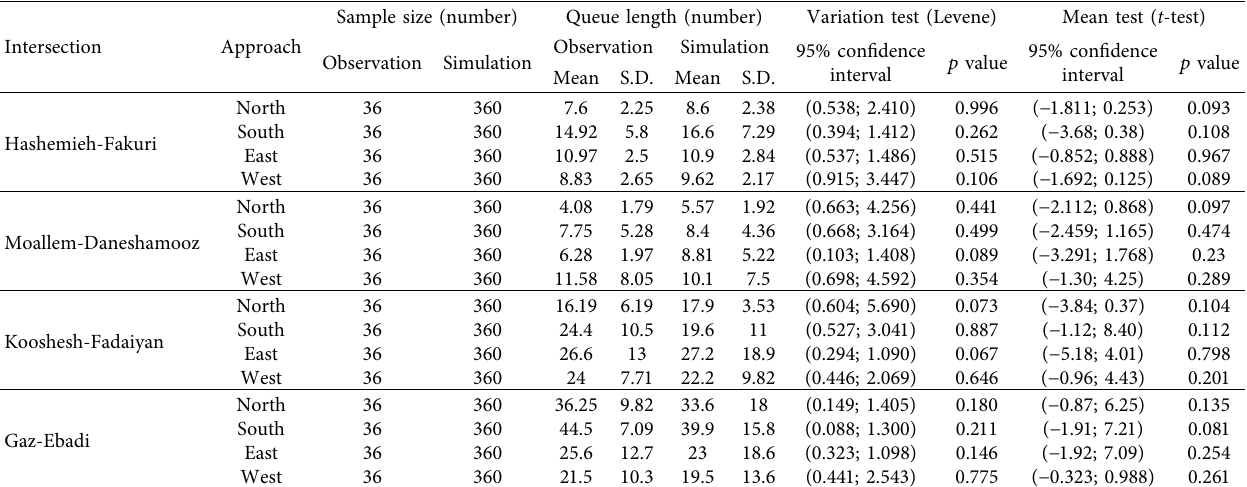
Table 7: Validation of simulation model’s queue length at the study